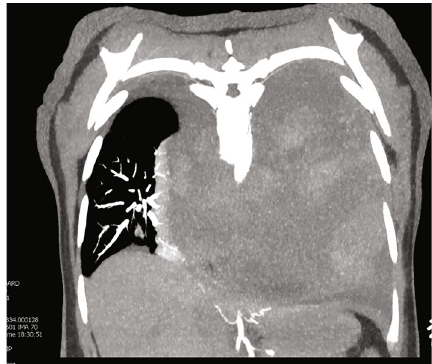
Figure 2: CT chest coronal MIP (maximum intensity projection) rightward mediastinal shift and partial right lung collapse secondary to left hemithoracic mass e ff ect.